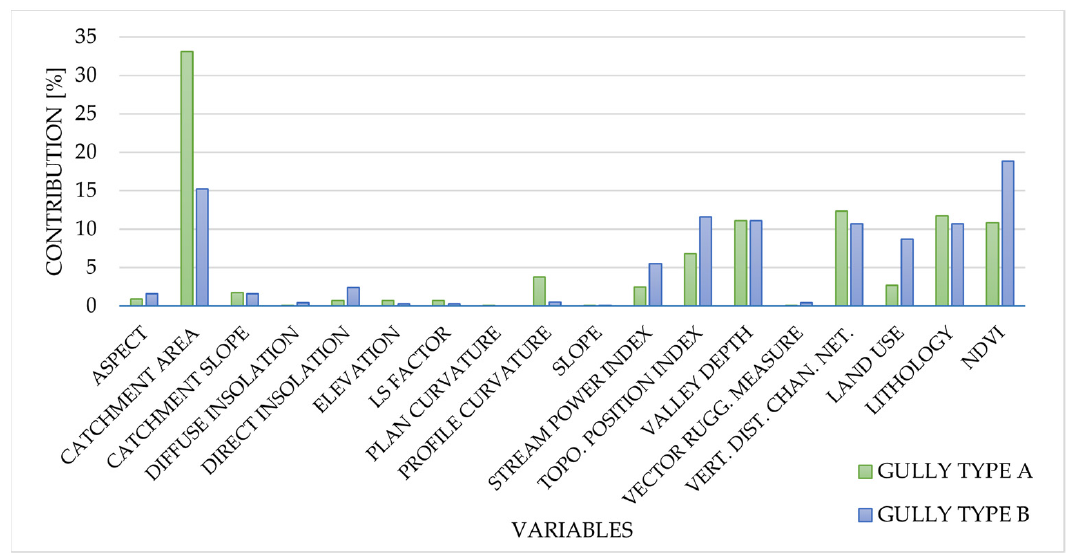
Figure 4. Relative importance of the environmental variables.